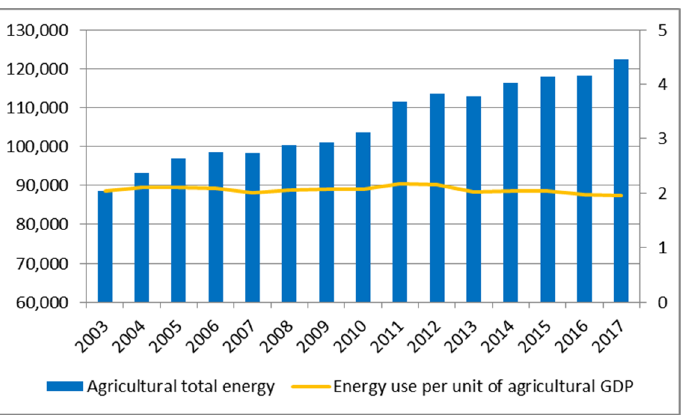
Figure 1. Agricultural energy use and energy use per unit of agricultural GDP in emerging economies. Data source: Agricultural total energy from the International Energy Agency and agricultural GDP from the FAOSTAT database. Energy use per unit of agricultural GDP is calculated by dividing the agricultural total energy by the agricultural GDP.